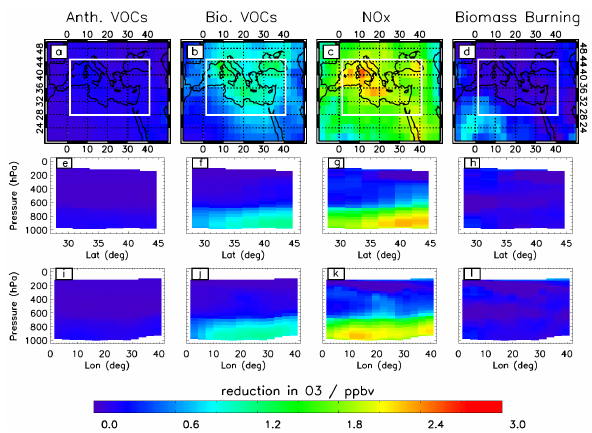
Fig. 6. Reduction in mean summertime (JJA) ozone (ppbv) resulting from a 20% reduction in five global precursor species emissions (from left to right: North American emissions, anthropogenic VOC, biogenic VOC, NOx and Asian emissions). The top row shows the reduction in surface level ozone over the Mediterranean region. The middle row shows zonal mean ozone reductions within the white boxes depicted in the maps on the top row. The bottom row shows meridional means of the ozone reduction, also within the white boxes. For zonal and meridional mean plots, only tropospheric model grid boxes are plotted (determined as where potential temperature < 380 K and PVU <2).